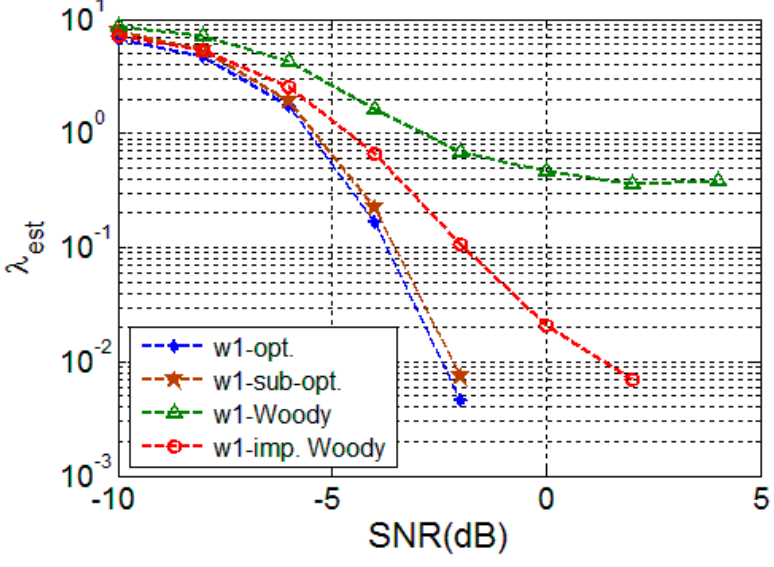
Figure 3. TDE performance for white random signal (w1).